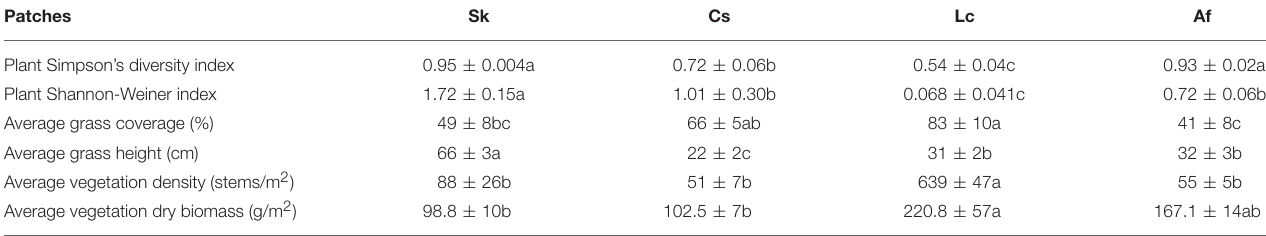
TABLE 1 | Patch conditions of O. asiaticus in different patches. Patches